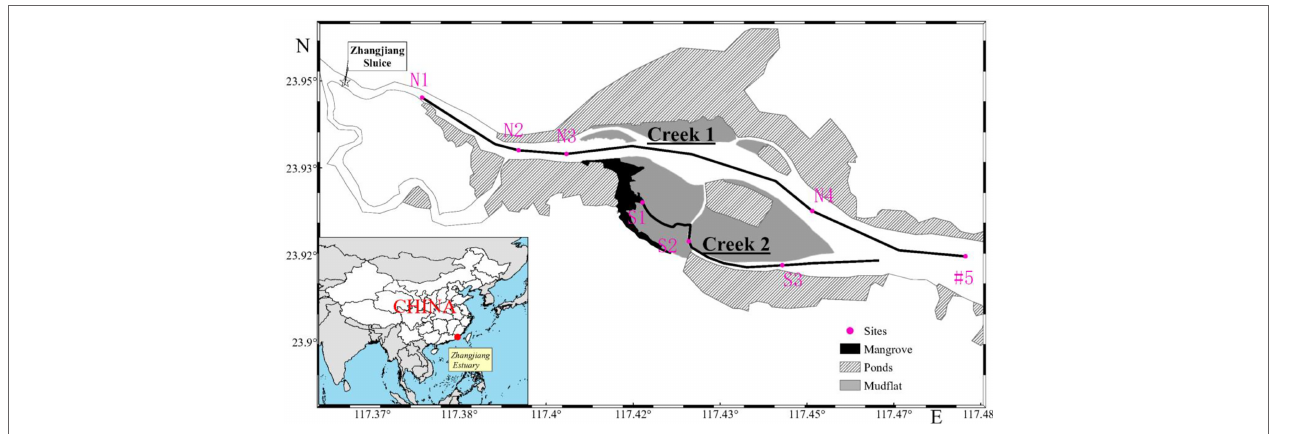
FIGURE 1 | Map of sampling sites in ZJE, Fujian, China.